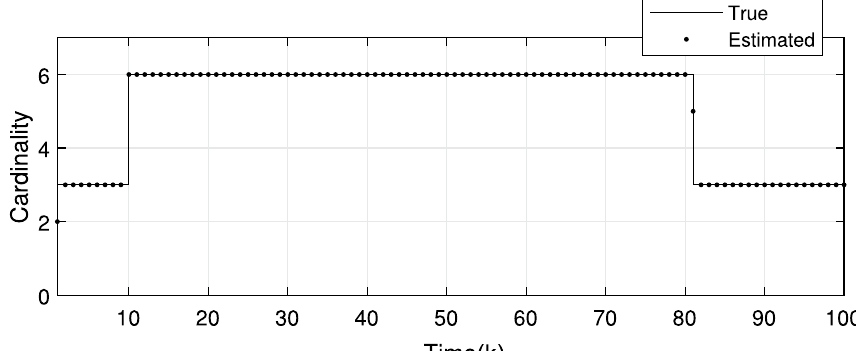
Fig. 15 Estimation of the number of all targets